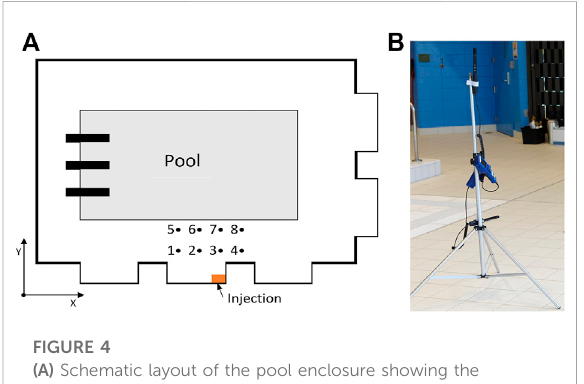
FIGURE 4 (A) Schematic layout of the pool enclosure showing the